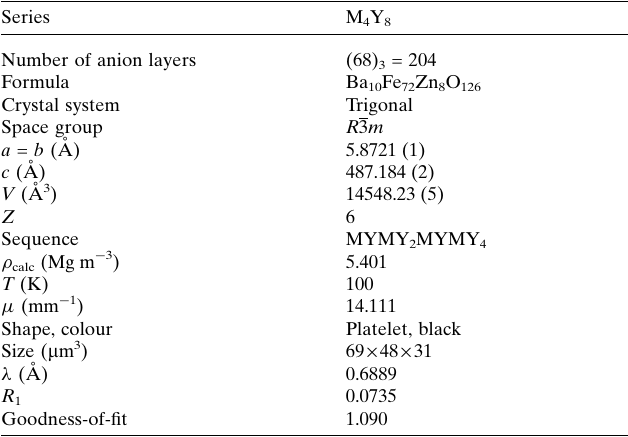
Table 6 Details of the single-crystal structure refinement for the (68) 3 hexaferrite.